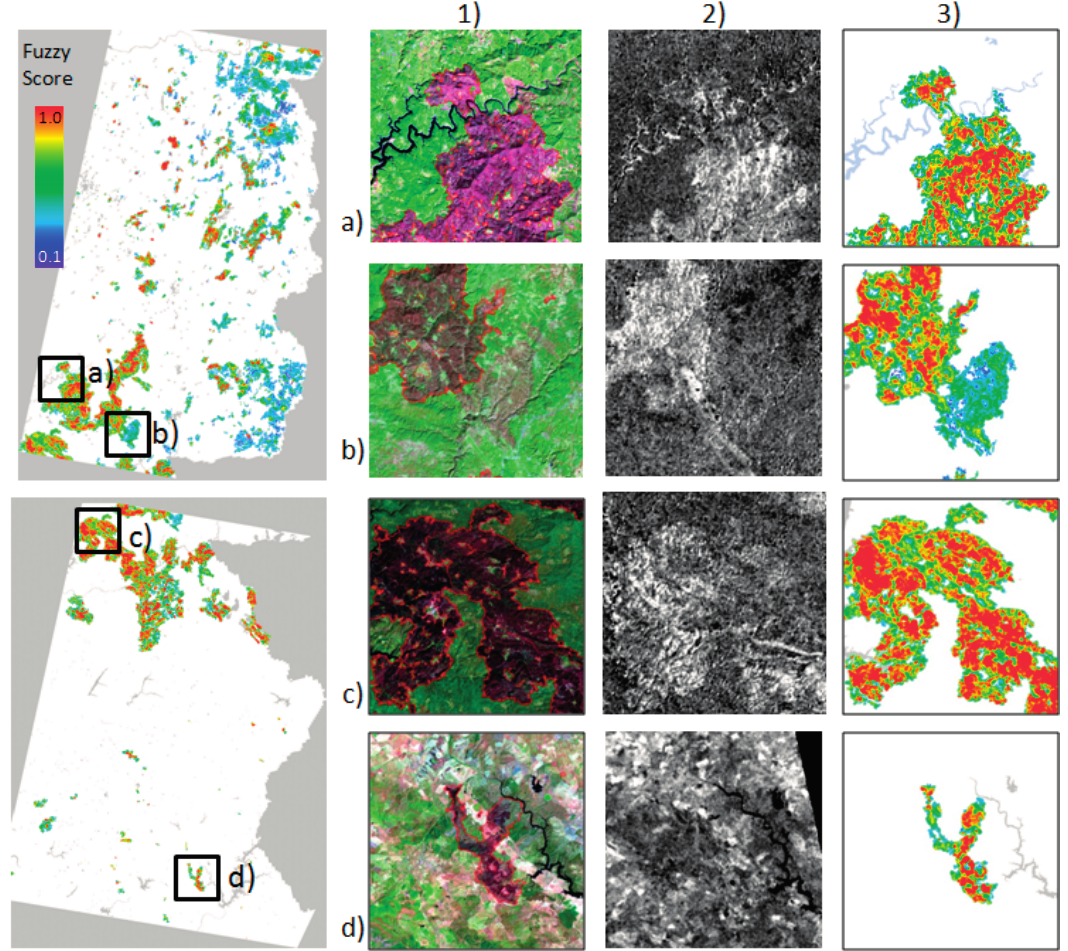
Figure 7. ( a–d ) Examples of the optical + SAR fuzzy score maps (column 3) over zoom areas of about 22 km × 22 km from TM frames 203/032 (rows a, b) and 203/033 (bottom) (rows c, d) compared to the Landsat TM (R-G-B 5-4-3) (column 1) and the ∆σ ° images (column 2). The red polygons are the reference fire